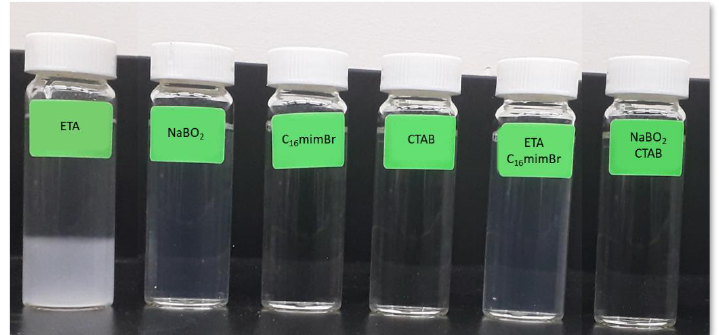
Figure 6. Compatibility of the chemical solutions with